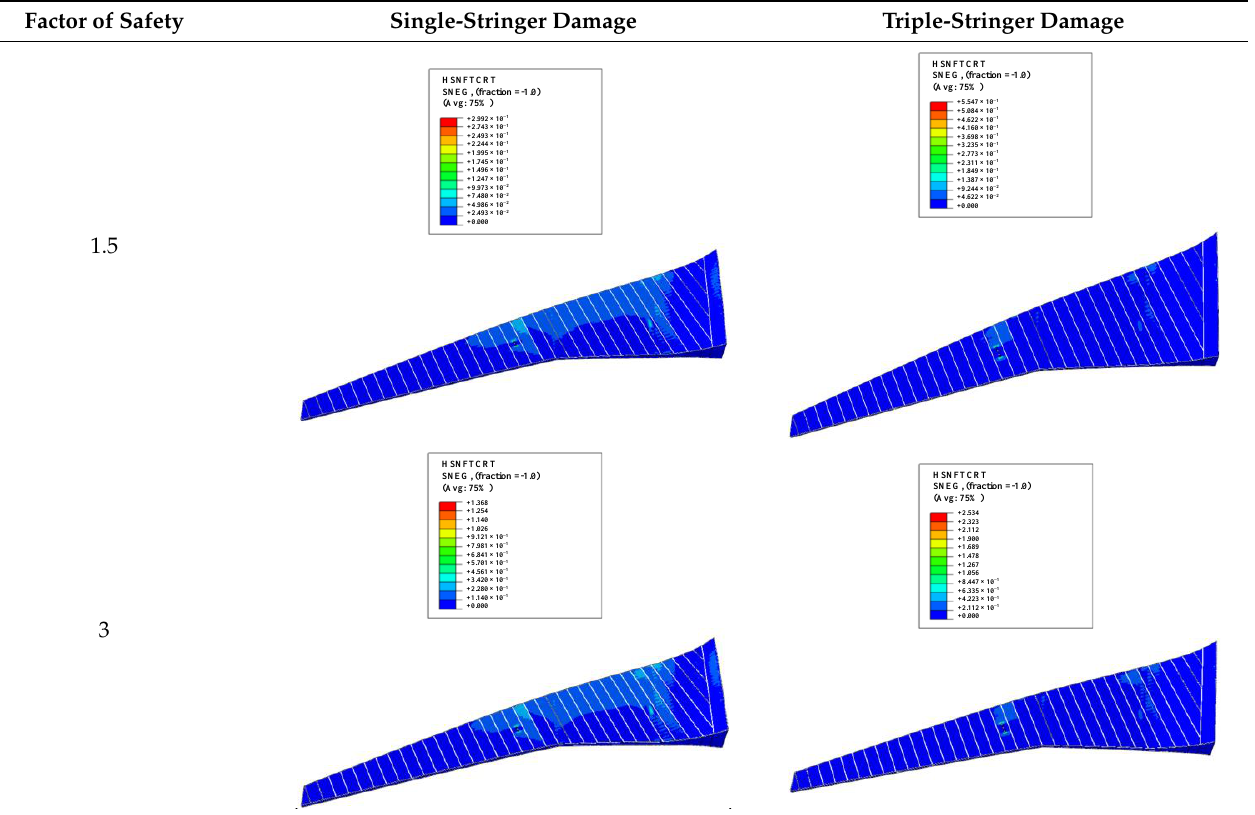
Table 8. Results of Hashin fiber tensile failure criterion of single-stringer and triple-stringer damage BWB wings at different values of F.o.S.